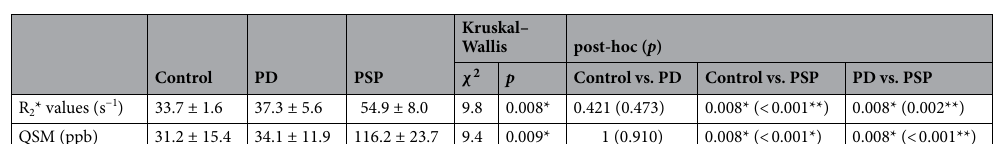
Figure 4. The line profile of normalized SWI intensity across the SN and RN. ( A ): SWI ( B ): Luxol fast blue staining with red lines for myelin distribution; ( C-I ), ( C-IV ): The line profile of normalized SWI intensity of healthy controls; ( C-II ), ( C-V ): The line profile of normalized SWI intensity of patients with PD; ( C-III ), ( C-VI ): The line profile of normalized SWI intensity of patients with PSP. The line profiles of ( C-I – C-III ) were delineated along the red line in SWI. The line profiles of ( C-IV – C-VI ) were delineated along the blue line in SWI. PD = Parkinson’s disease; PSP = progressive supranuclear palsy; SN = substantia nigra; RN = red nucleus; WM = white matter between SN and RN. ( A , B ) were generated from MATLAB (version R2016a, MathWorks, Natick, MA, USA).